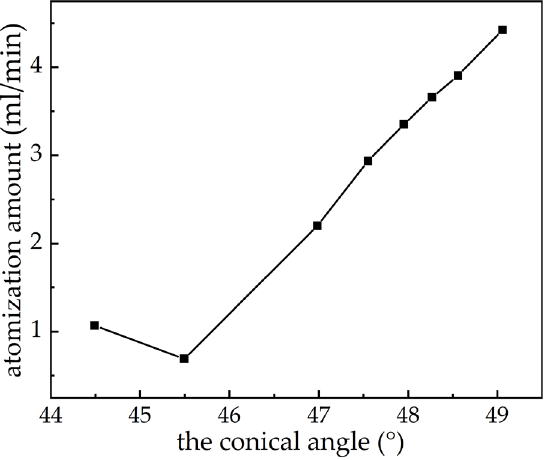
Figure 7. Theoretical relationship between atomization amount and the conical angle.